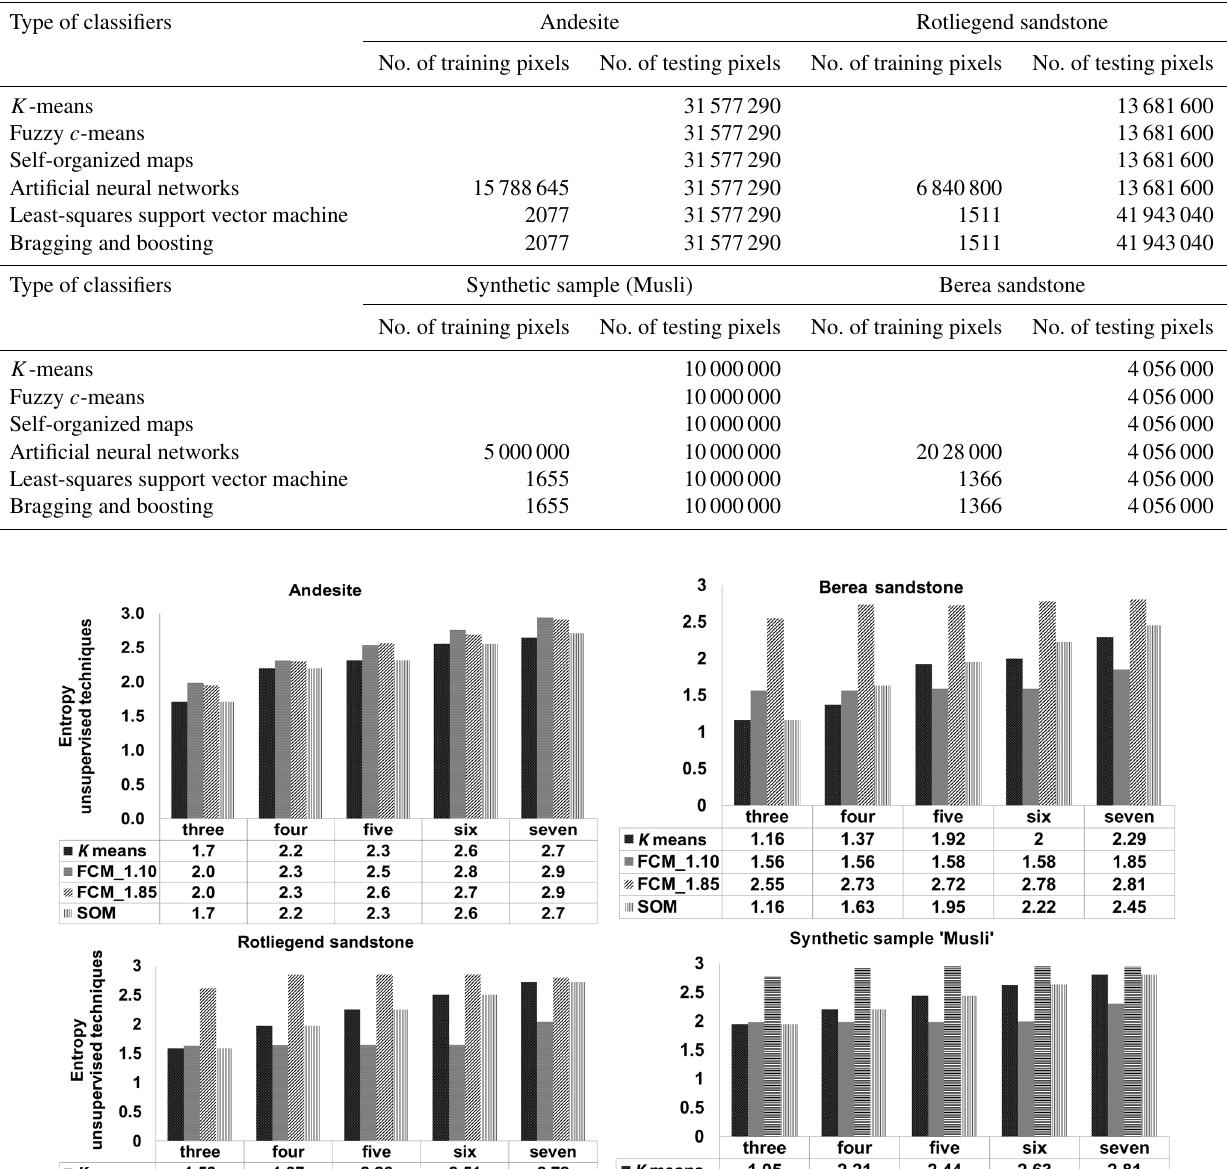
Table 1. The number of pixels used for training and testing the classification model.